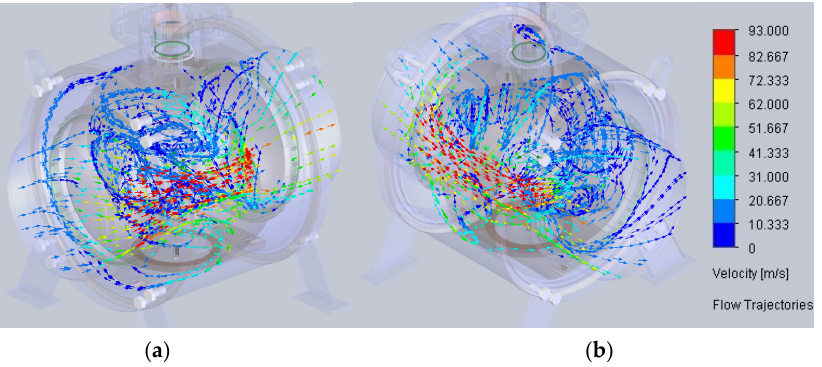
Figure 9. Velocity line trajectories for a 60° closure angle: ( a ) upstream view; ( b ) downstream view.